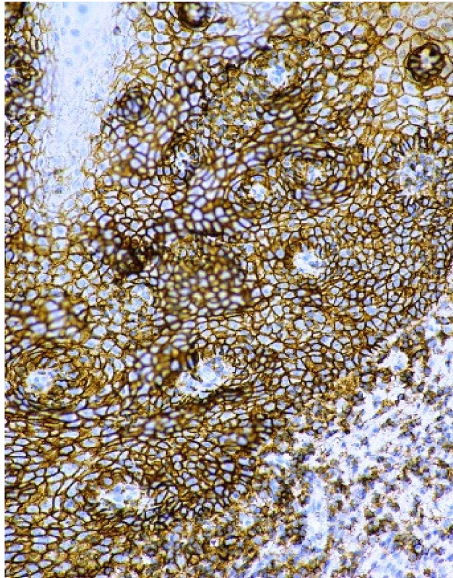
Figure 7. Overexpression of CD44 protein in the cell membranes of epithelium in oral leukoplakia. Immunoperoxidase, anti-CD44, original magnification 200 ×